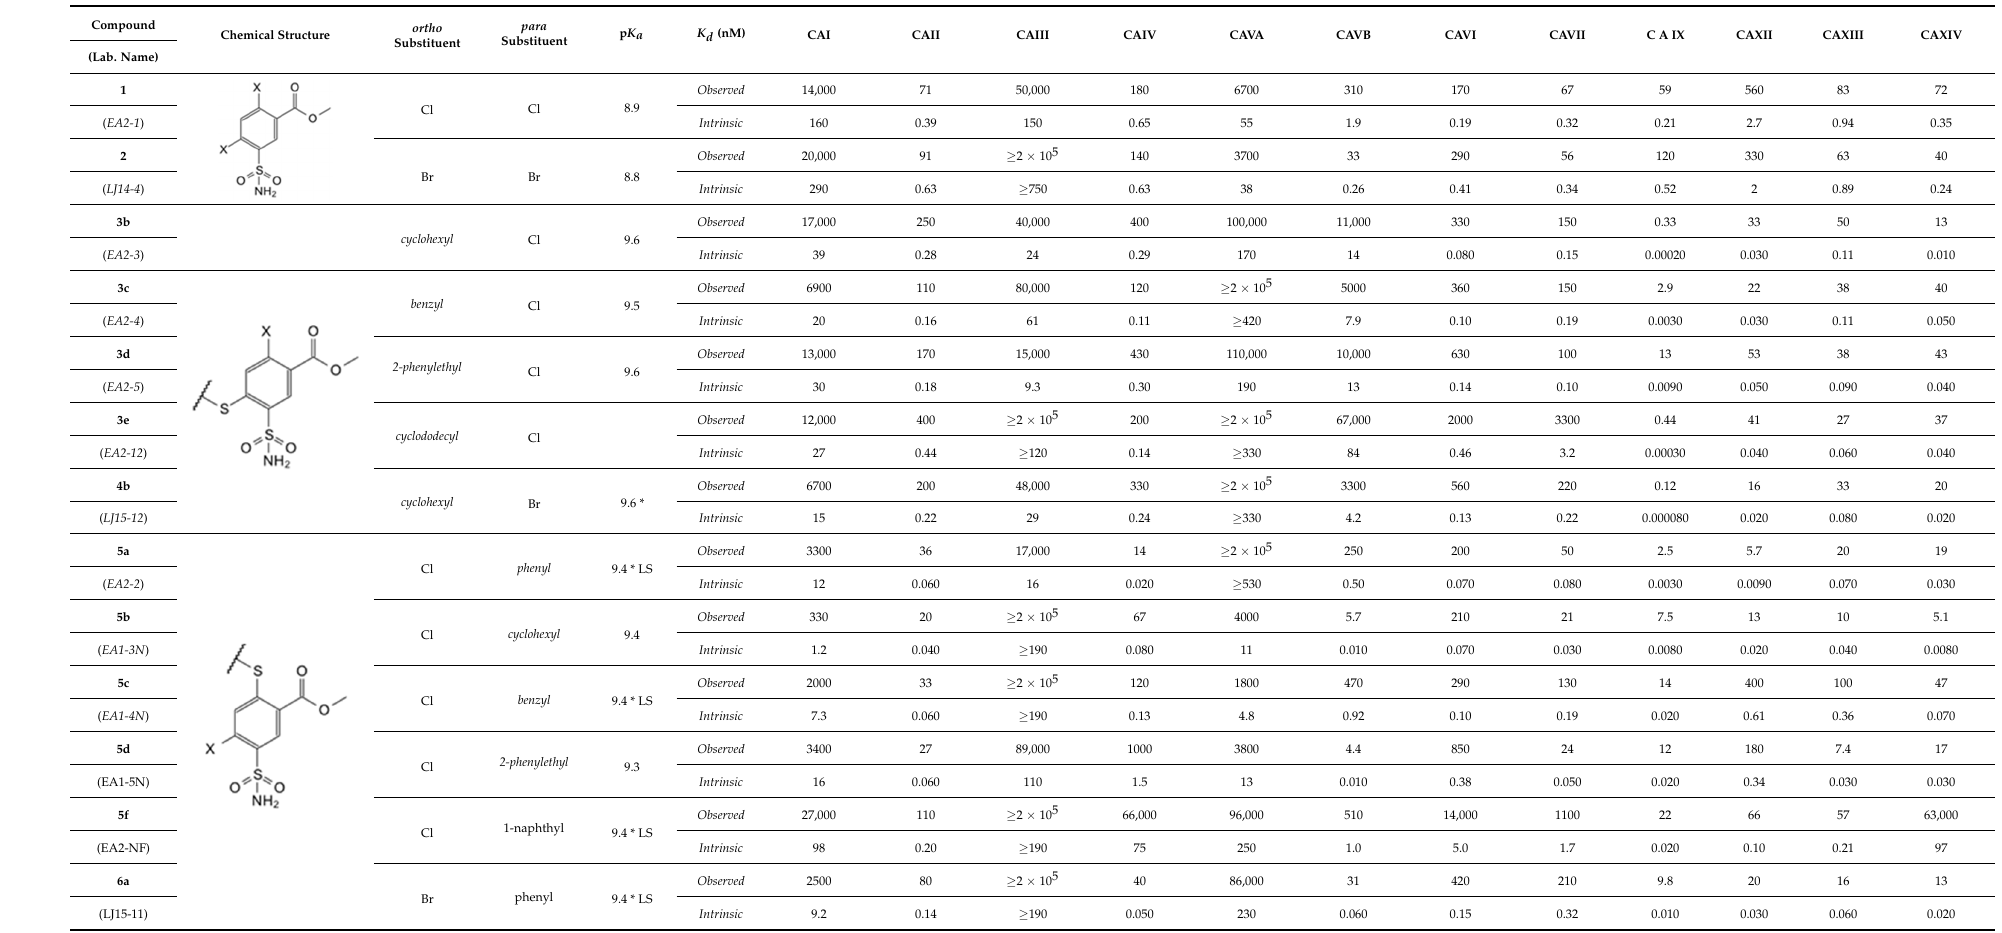
Table 2. Intrinsic ( K d_intr ), calculated according to the model, and observed ( K d_obs at pH = 7.0), determined by the fluorescent thermal shift assay, disso- ciation constants, K d (nM), of investigated compounds binding to all catalytically active human carbonic anhydrases (CAs) at 37 °C. p K a values of the sulfonamide group were calculated from spectra at various pH as described in Methods and are listed to all compounds. Some compounds exhibited poorer solubility, which was observed visually and prompted in absorption spectra. Therefore, for such compounds, the p K a value was assigned based on the average value of the other compounds in that group and is marked with *.